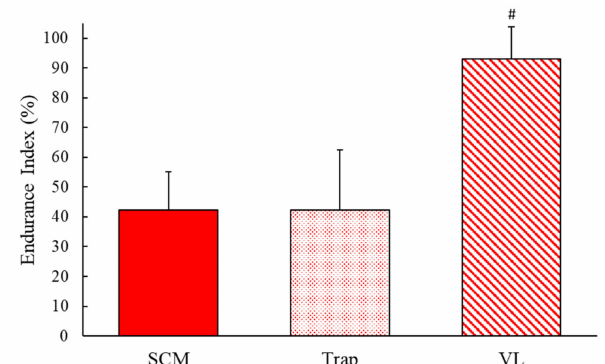
Figure 3. The endurance index mean and standard deviation of the sternocleidomastoid, trapezius, and vastus lateralis muscles. # shows a significant di ff erence from both SCM and trap, p <